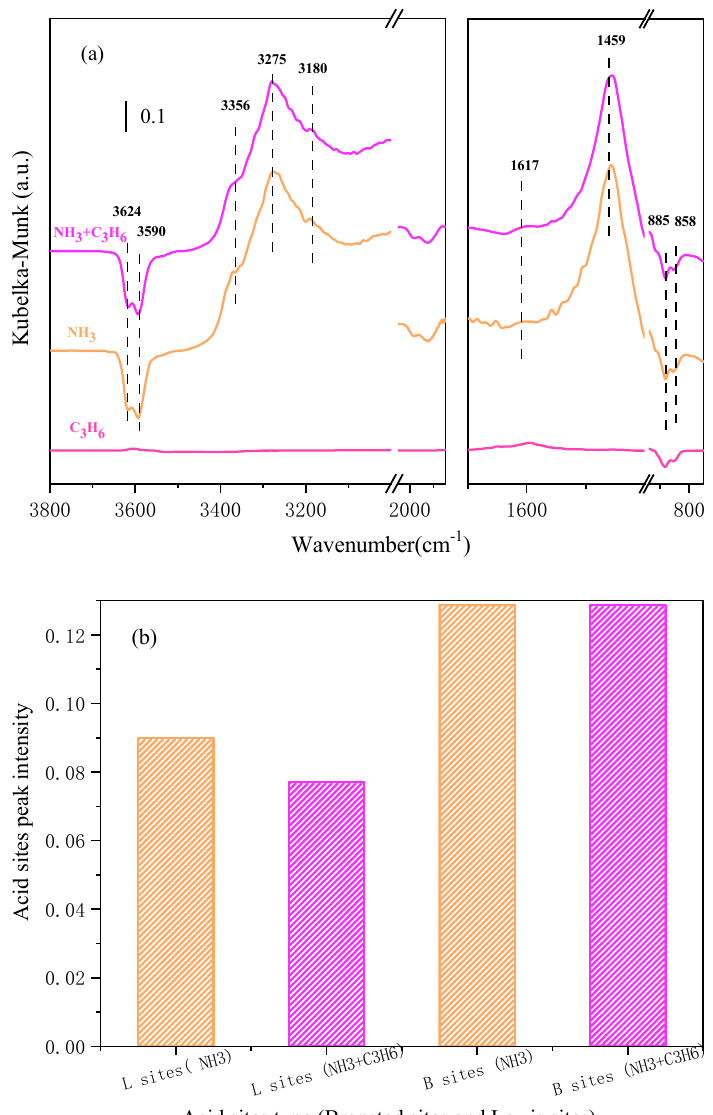
Figure 9. ( a ) IR characteristic peak spectra when NH 3 , C 3 H 6 , and NH 3 +C 3 H 6 were, respectively, chemisorbed over Cu-SAPO-34 catalysts at 200 °C, ( b ) the change of peak intensity over the Lewis acid site (885 cm − 1 ) and the Brønsted acid sites (3624 cm − 1 ) with or without C 3 H 6 .